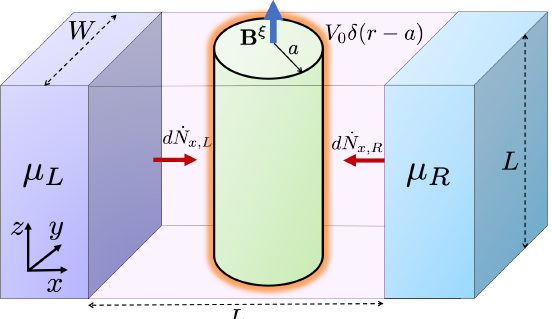
Figure 1. A pictorial description of the system under consideration: A WSM slab of dimensions L × W , with a cylindrical region of radius a submitted to a combination of torsional strain and an external magnetic field B ξ = ( B + ξ B S ) ˆz and an RDSP on the boundary surface of the